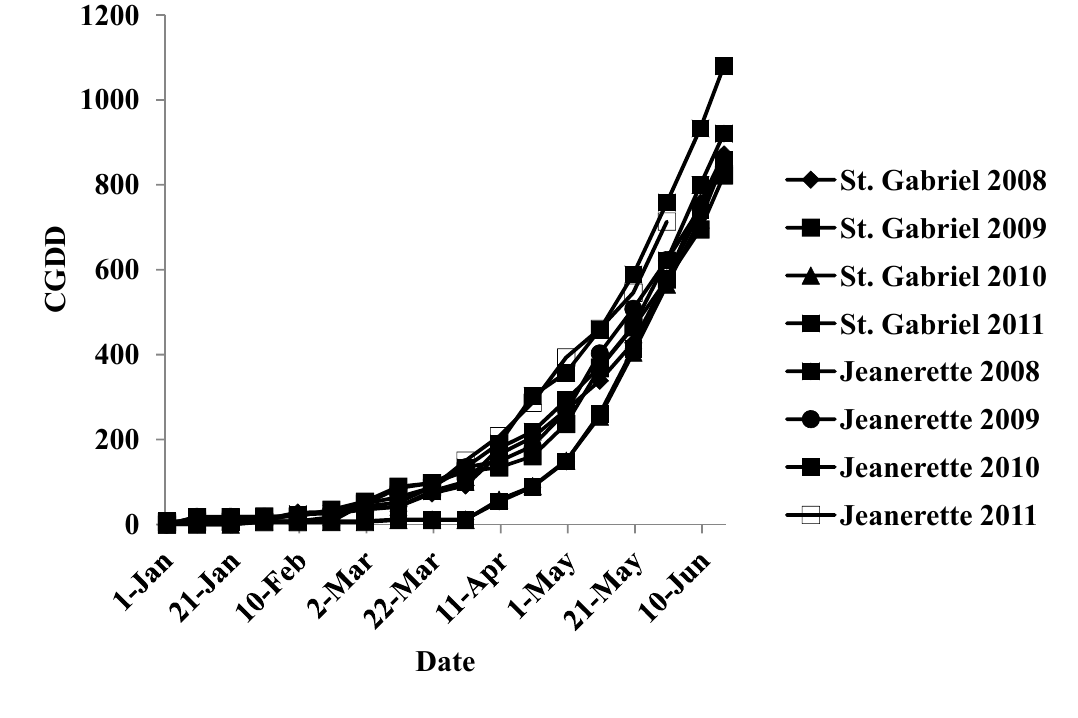
Figure 1. Total accumulation of growing degree days (CGDD) as a function of day of the year from the beginning of January until